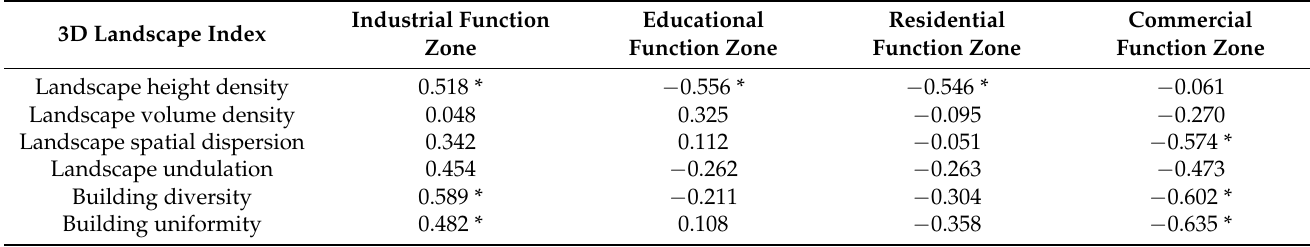
Table 8. Correlation between 3D landscape index of functional zones and PM 2.5 concentration.